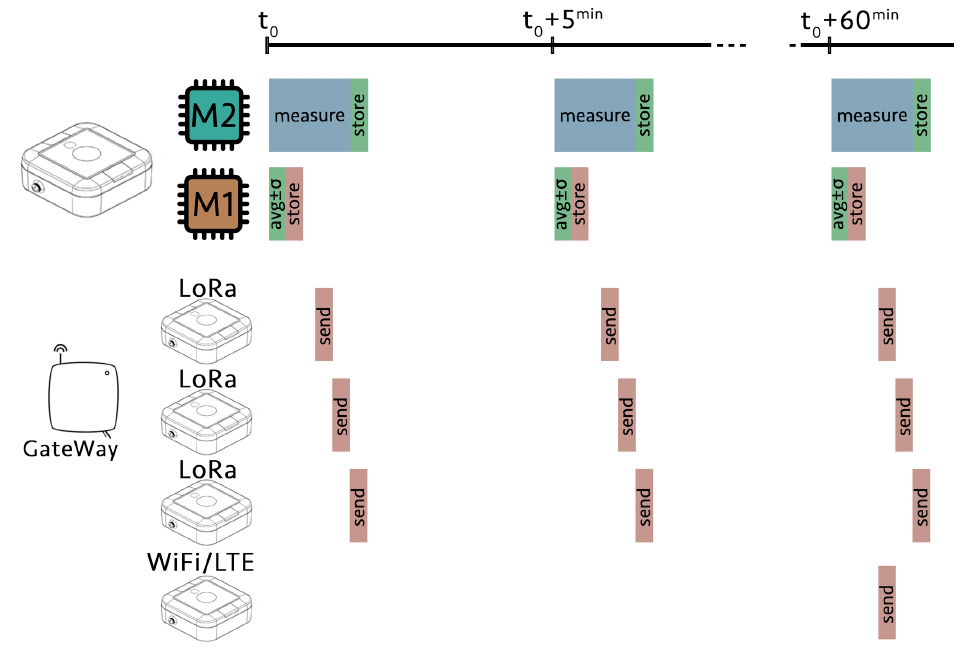
Figure 2. Measurement and communication diagram of the SG-WAS photometer. Each device has two microcontrollers: M2 takes ten NSB measurements and stores them temporarily; M1 calculates the average and uncertainty of the data set taken in the previous slot, and stores them until they are transmitted to the central hub. This process is repeated every 5 min. In the LoRa version, the GateWay assigns a 6 s slot every 5 min to each photometer to send its measurements and synchronize its timestamp for the next cycle. The GateWay sends the measurements of all the devices connected to it to the server. In the WiFi and LTE-M version, the measurements are directly sent to the server once every hour and M1 is continuously synchronized with the network. During the rest of the time, both microcontrollers remain in a deep sleep state, so the battery consumption is extremely low. To reduce power consumption as much as possible, two independent processes are carried